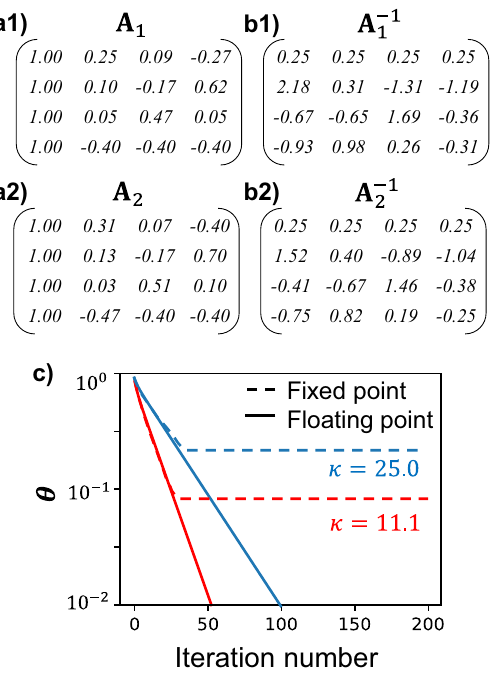
Figure 1. Two 4 × 4 matrices ( a ) and their inverses ( b ) in fixed-point iterative matrix inversion solver. A 1 has a κ of 25, and A 2 has a κ of 11.1. All matrices are stored in floating-point format but displayed with two decimal points. ( c ) Normalized error of the iterative solutions θ k vs. the iteration number k for the inversion of A 1 ( κ =25.0) and A 2 ( κ =11.1) using 8-bit fixed-point Richardson